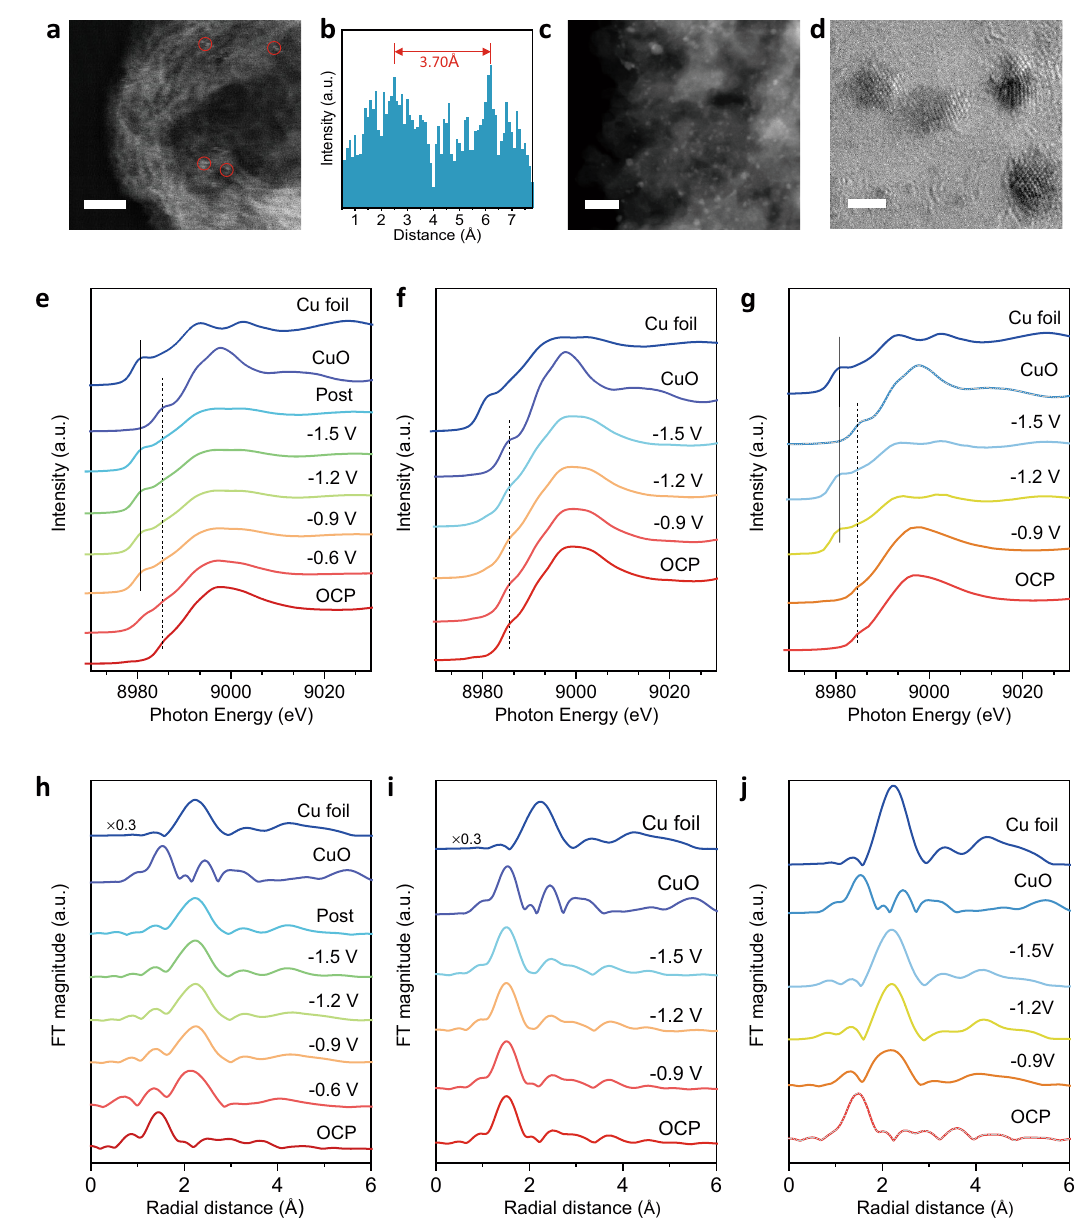
Fig. 3 | Ex-situ TEM images and operando XAS. a Representative HAADF – STEM images of Hex-2Cu-O/KB (1:10 dilution) showing the presence of isolated Cu pairs markedbyredcircles. b Line-scanintensitypro fi ledrawnupononeofthediatomic Cupairs. c , d High-resolutionTEM( c )andCs-TEM( d )imagesofHex-2Cu-O/KBafter